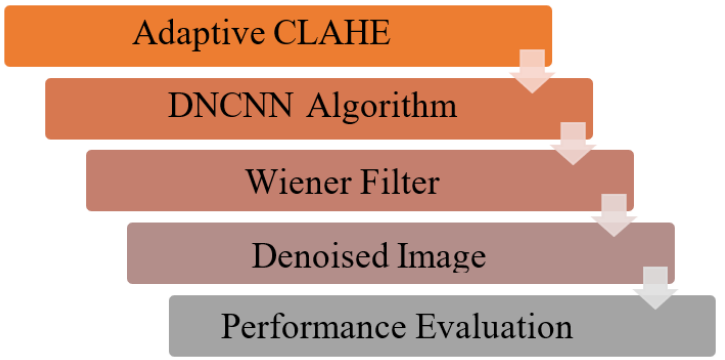
Figure 1. Pre-processing methodology.